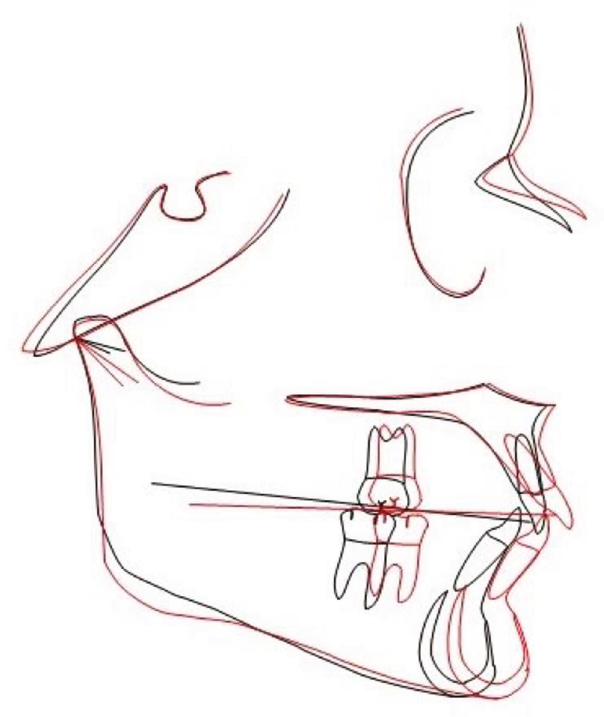
Figure 21: Cephalometric fi nal